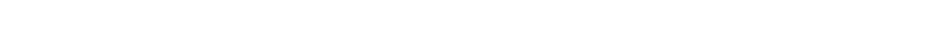
FIGURE 4 | Experiment 2 results. The difference indices for cathodal tDCS onWM accuracy. Error bars represent the